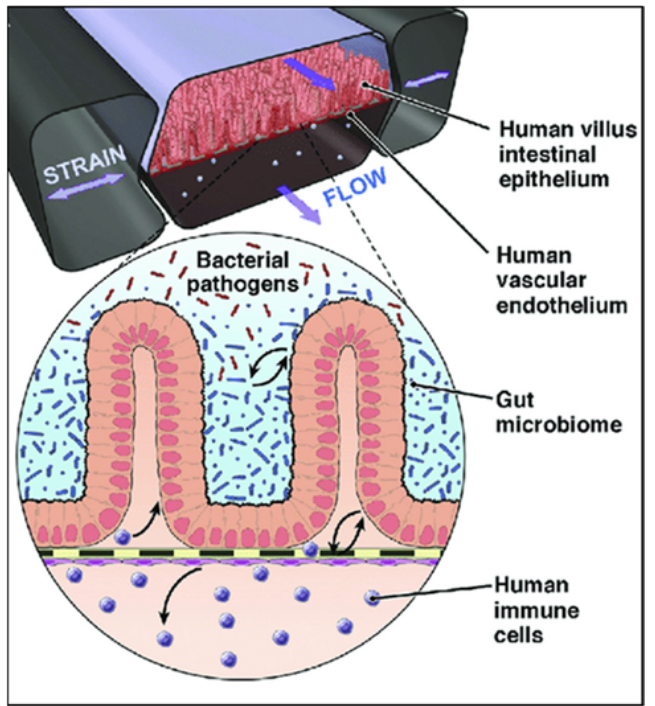
Figure 5. Gut-on-chip microfluidic device with human villus intestinal epithelium and human vascular endothelium formed on a flexible membrane with an active flow and peristalsis-like motion and capabilities to co-culture with bacteria and human immune cells. Adapted with permission